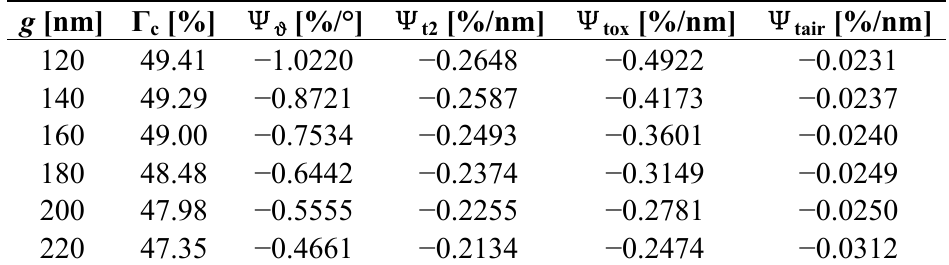
Table 1. Fabrication tolerances with respect to Γ case of absorption sensing